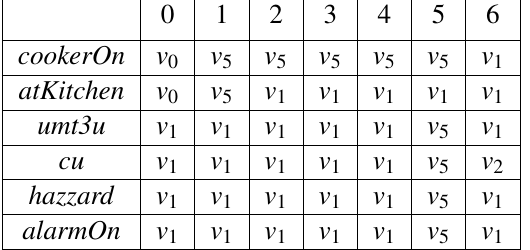
Table 3. An Example with Uncertainty of Rule(5) in Scenario 2